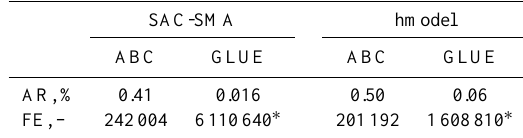
Table 3. Computational efficiency of GLUE and ABC for the French Broad river basin data set: Acceptance rate (AR, %) and total number of SAC-SMA and hmodel function evaluations (FE) required to sample N = 1000 behavioral solutions.